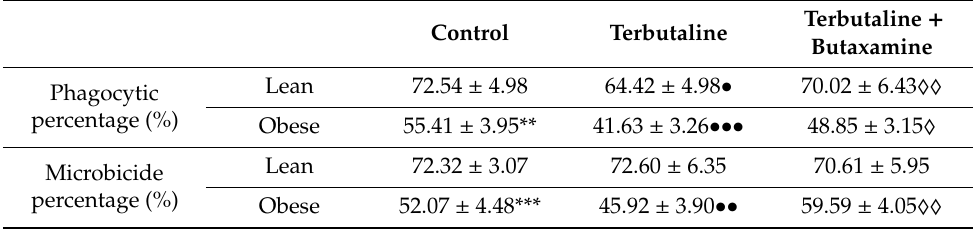
Table 2. E ff ect of β 2 adrenergic agonist terbutaline and β 2 adrenergic antagonist butaxamine on percentage of phagocytic monocytes and percentage of microbicidal monocytes from lean and obese